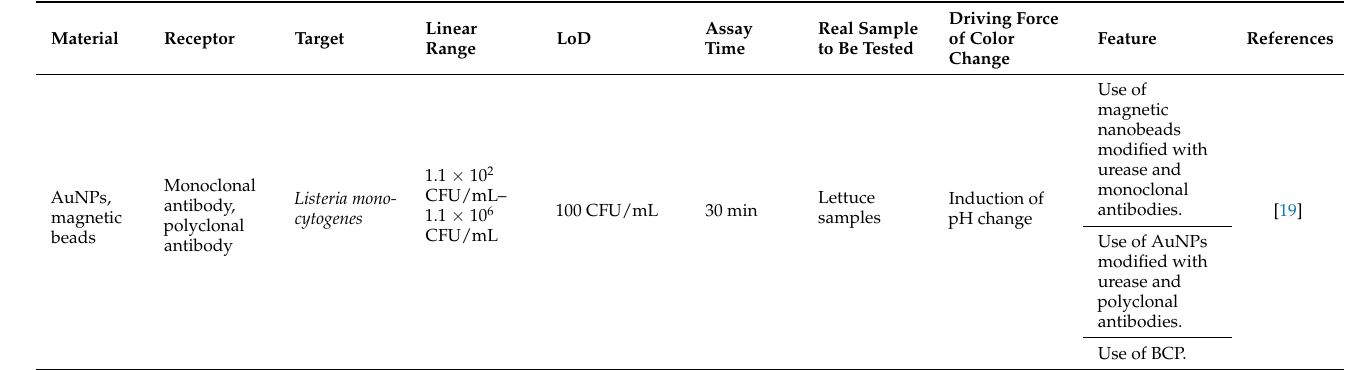
Table 1. Colorimetric sensing systems for the detection of pathogenic bacteria and toxins a